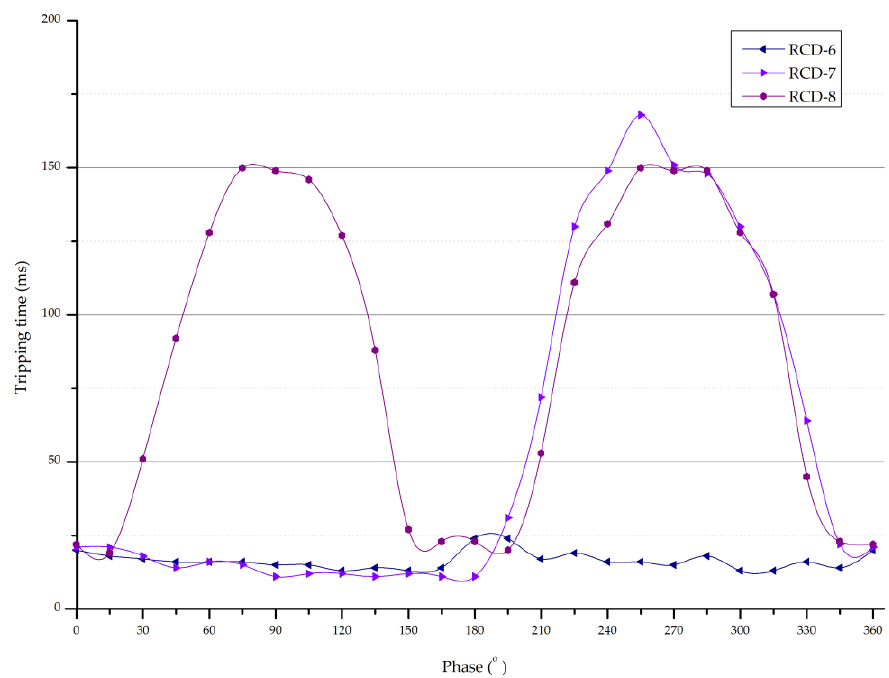
Figure 16. The dependencies of RCD-6–8 break times versus initial phase of the test current ( I ∆ = 30 mA, 50 Hz).